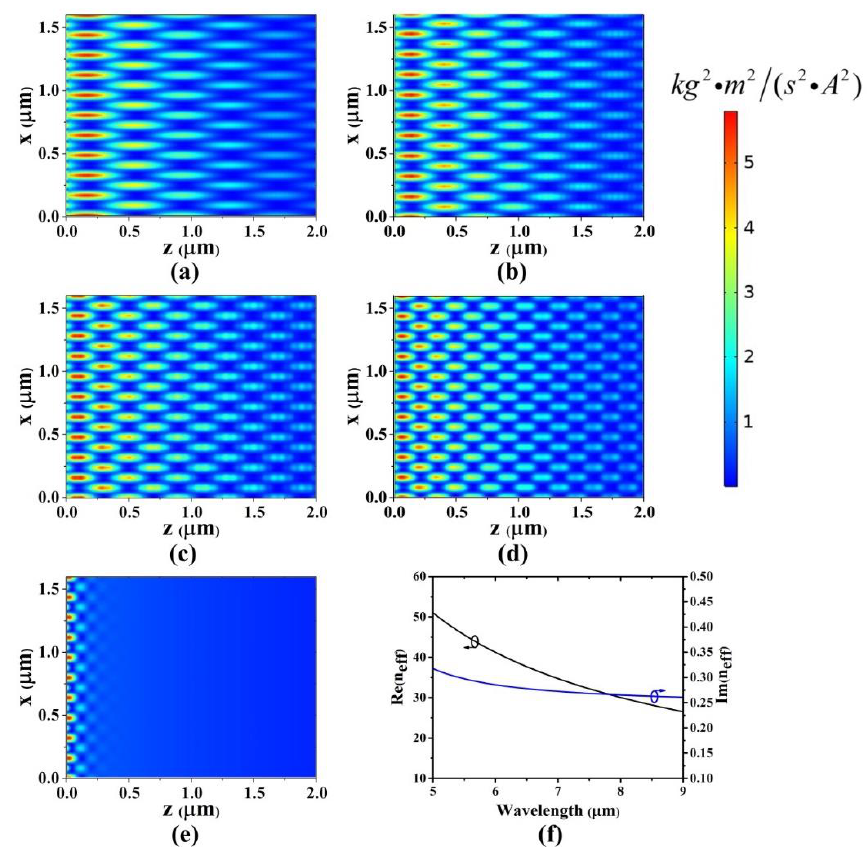
Figure 2. |E| 2 field distribution of graphene plasmonic Talbot effect with different incident wavelengths. The chemical potential is 0.3 eV, period is 160 nm, and the input wavelength is ( a ) 𝜆 0 =7 μm. ( b ) 𝜆 0 = 8 μm. ( c ) 𝜆 0 = 9 μm. ( d ) 𝜆 0 = 10 μm. ( e ) 𝜆 0 = 11 μm. ( f ) The imaginary part (described as Im(𝑛 𝑒𝑓𝑓 ) = Imag(𝛽 𝑘 0 ⁄ ) ) and the real part (denoted by Re(𝑛 𝑒𝑓𝑓 ) = Real(𝛽 𝑘 0 ⁄ ) ) of the effective refractive index of graphene supported plasmon as a function of the incident wavelength which is obtained from MATLAB.